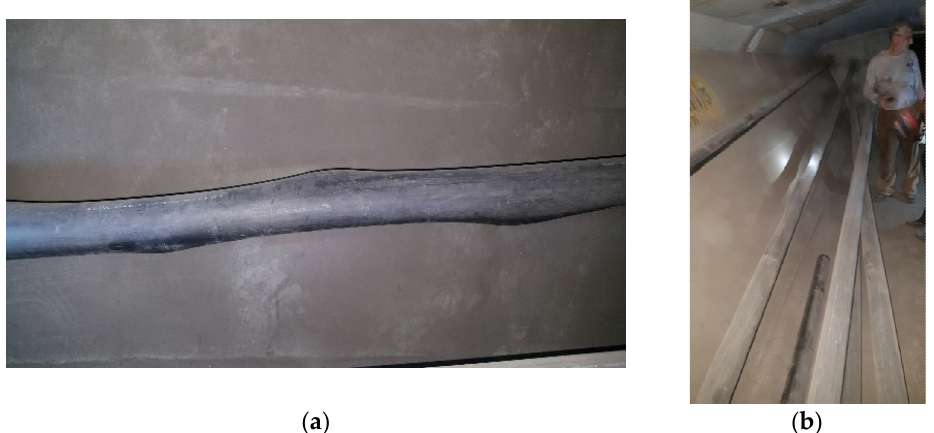
Figure 13. Spot inspection activities (case study) to verify the current condition of the bridge; ( a ) one of defected external tendons, ( b ) inspectors during spot inspection.